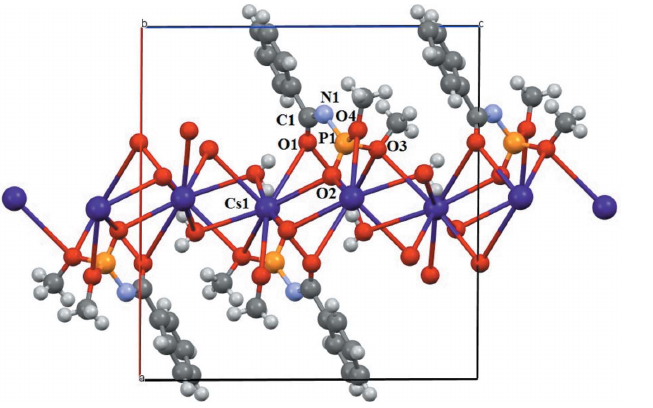
Figure 1 Polymeric chain of the title compound extending along the [001] crystallographic direction.